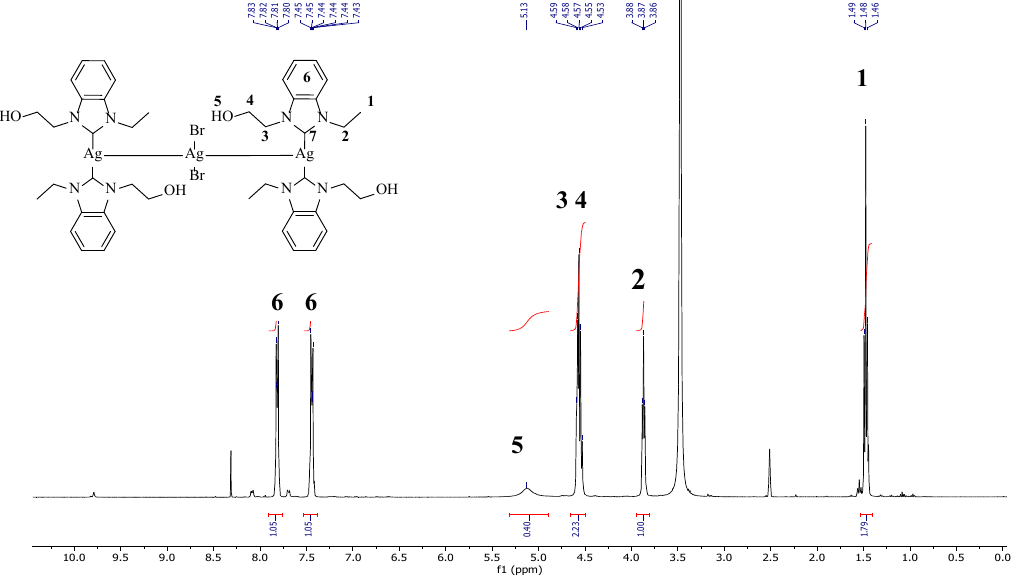
Figure 1. The 1 H NMR data for the hydroxyethyl-substituted Ag-NHC complex 1.